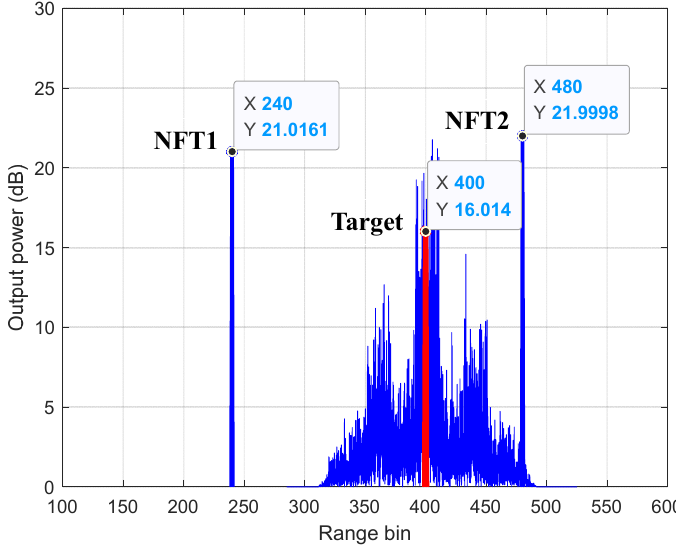
Figure 8. Analysis results of new jamming range bin under non-adaptive beamforming.